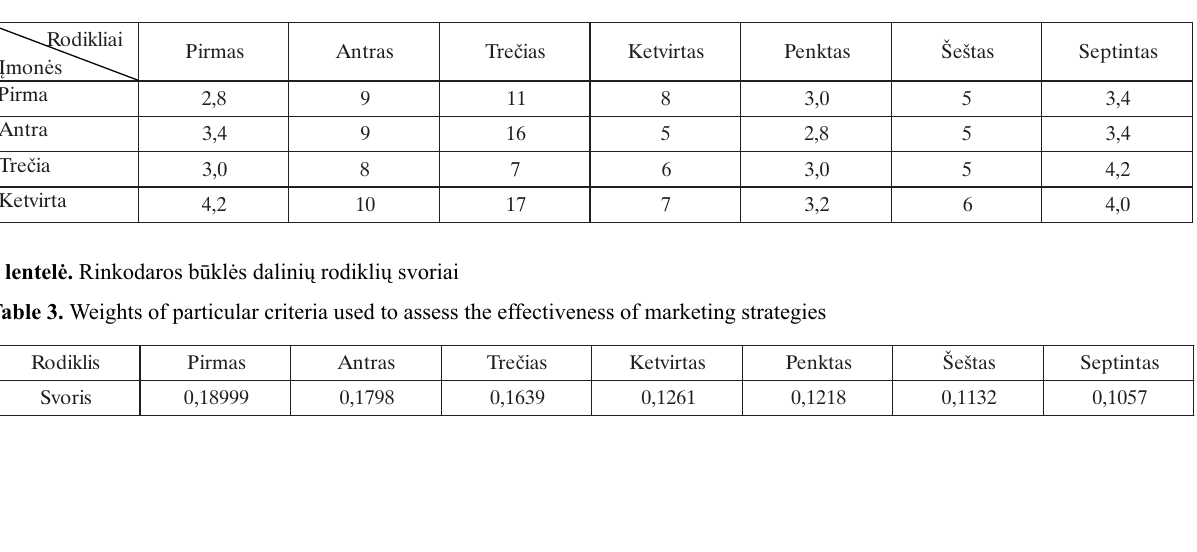
Table 2 . Average values of particular criteria used to assess the effectiveness of enterprise marketing strategies